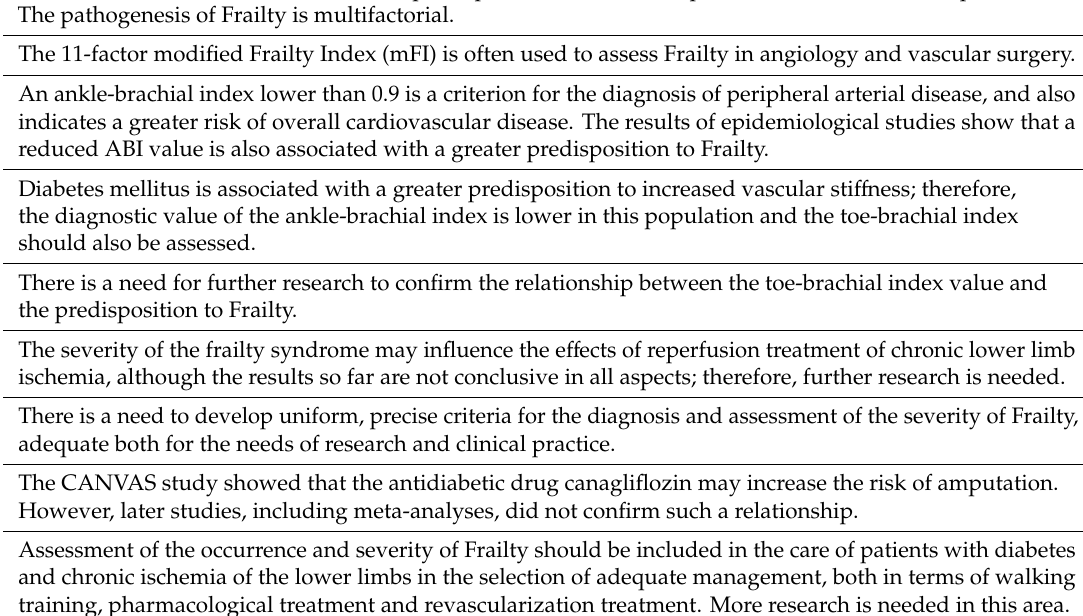
Table 4. The most important findings of our review of the